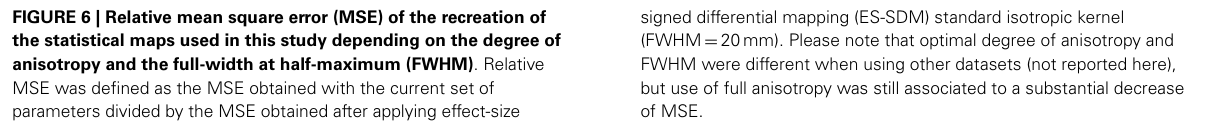
signed differential mapping (ES-SDM) standard isotropic kernel (FWHM = 20mm). Please note that optimal degree of anisotropy and FWHM were different when using other datasets (not reported here), but use of full anisotropy was still associated to a substantial decrease of